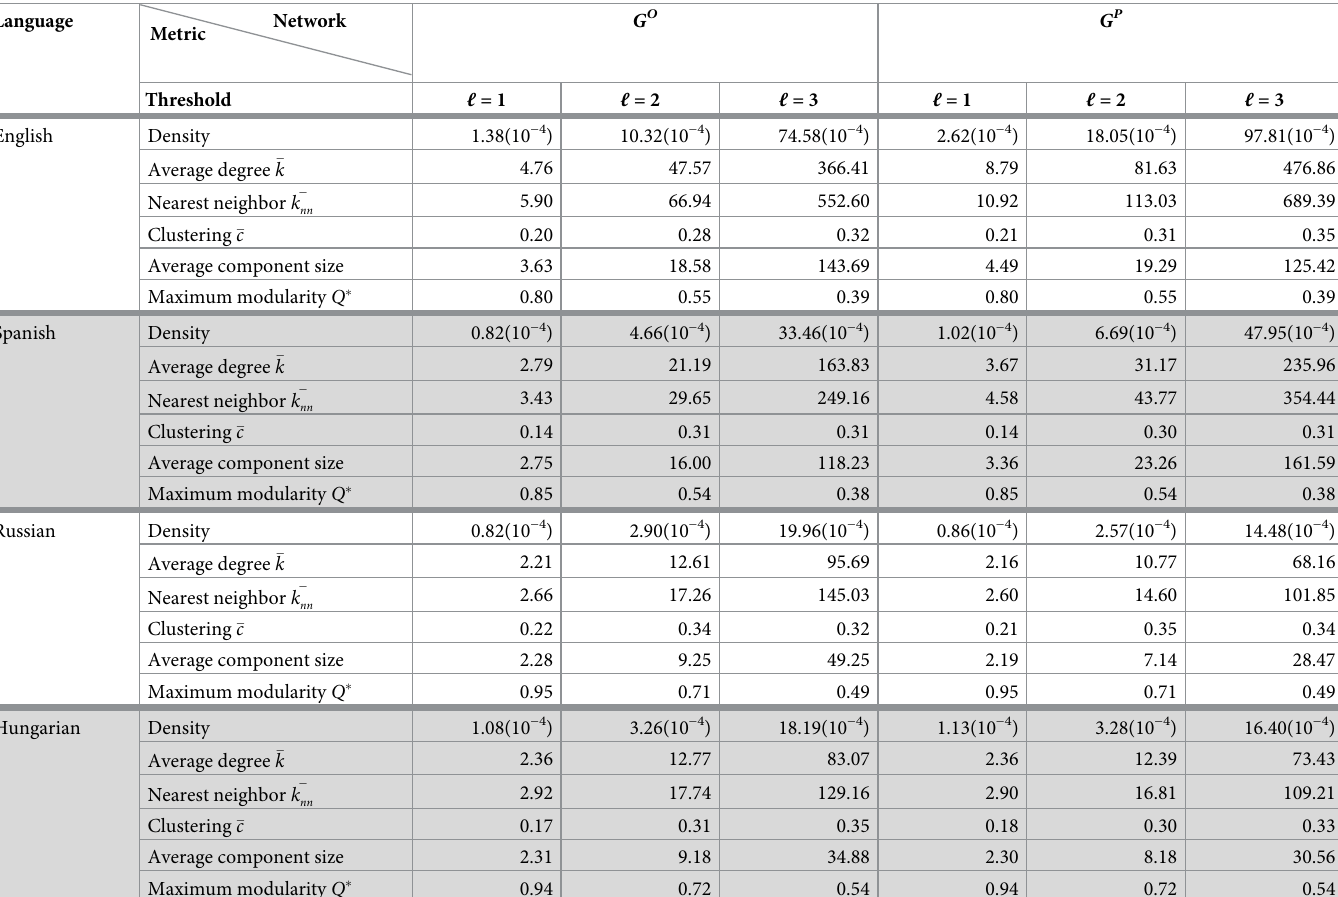
Table 1. Results for the basic topological network quantities obtained from the ortographic ( G O ) and phonological ( G P ) networks.